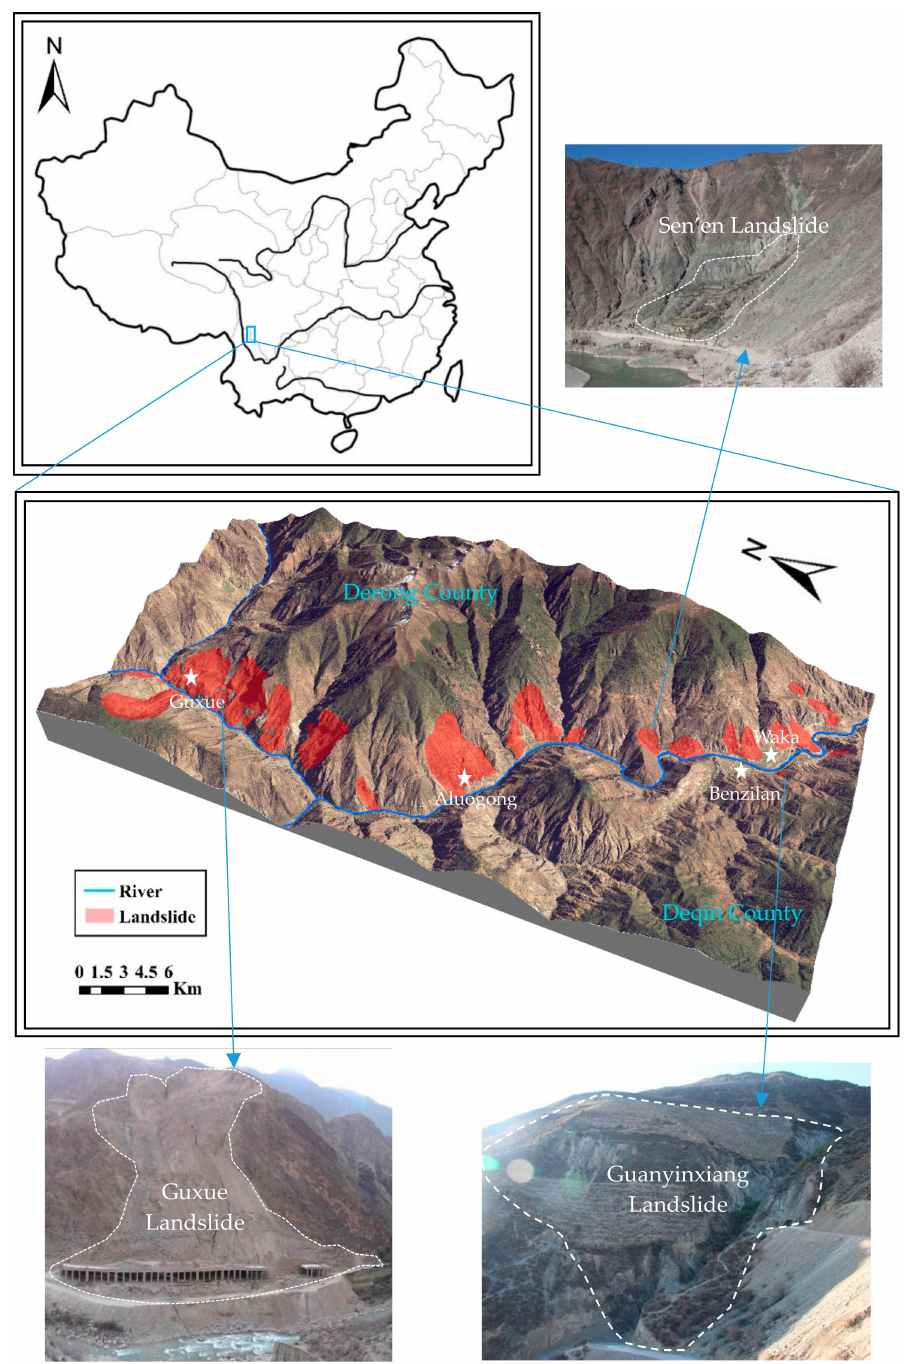
Figure 1. Geographical position and landslide inventory of the study